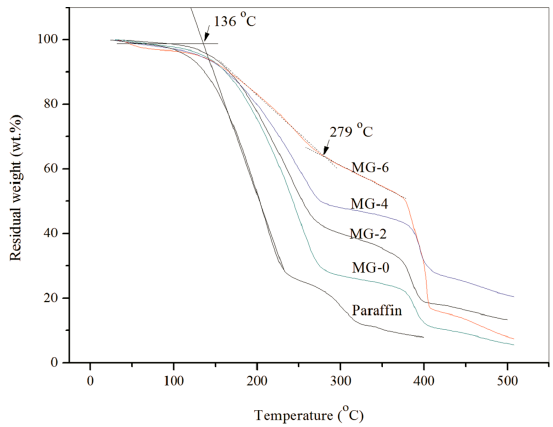
Figure 9. Thermogravimetric analysis (TGA) curves of pure paraffin and microPCM samples.